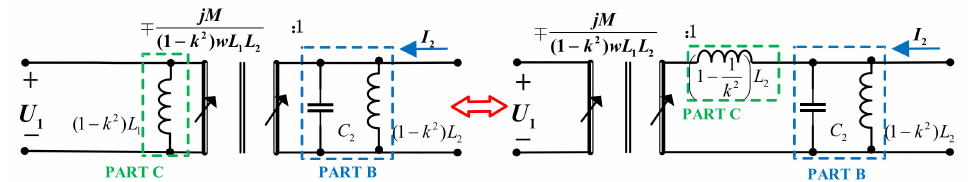
Figure 11. The equivalent model of the I_CV_CC circuit.